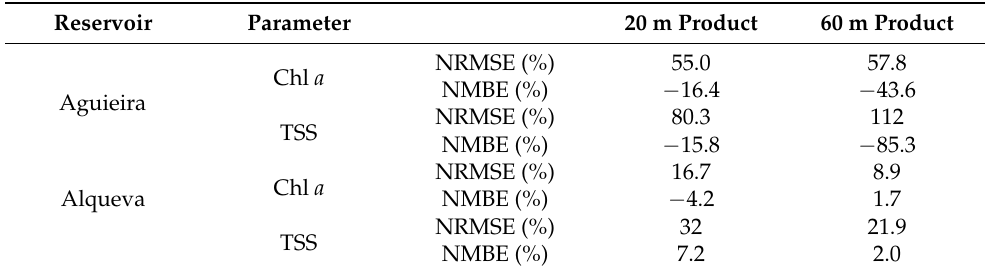
errors were negative, indicating an underestimation of in-situ values by SNAP-C2RCC. Table 3. Normalized root mean squared error (NRMSE) and the normalized mean bias error (NMBE) results for the two reservoirs.